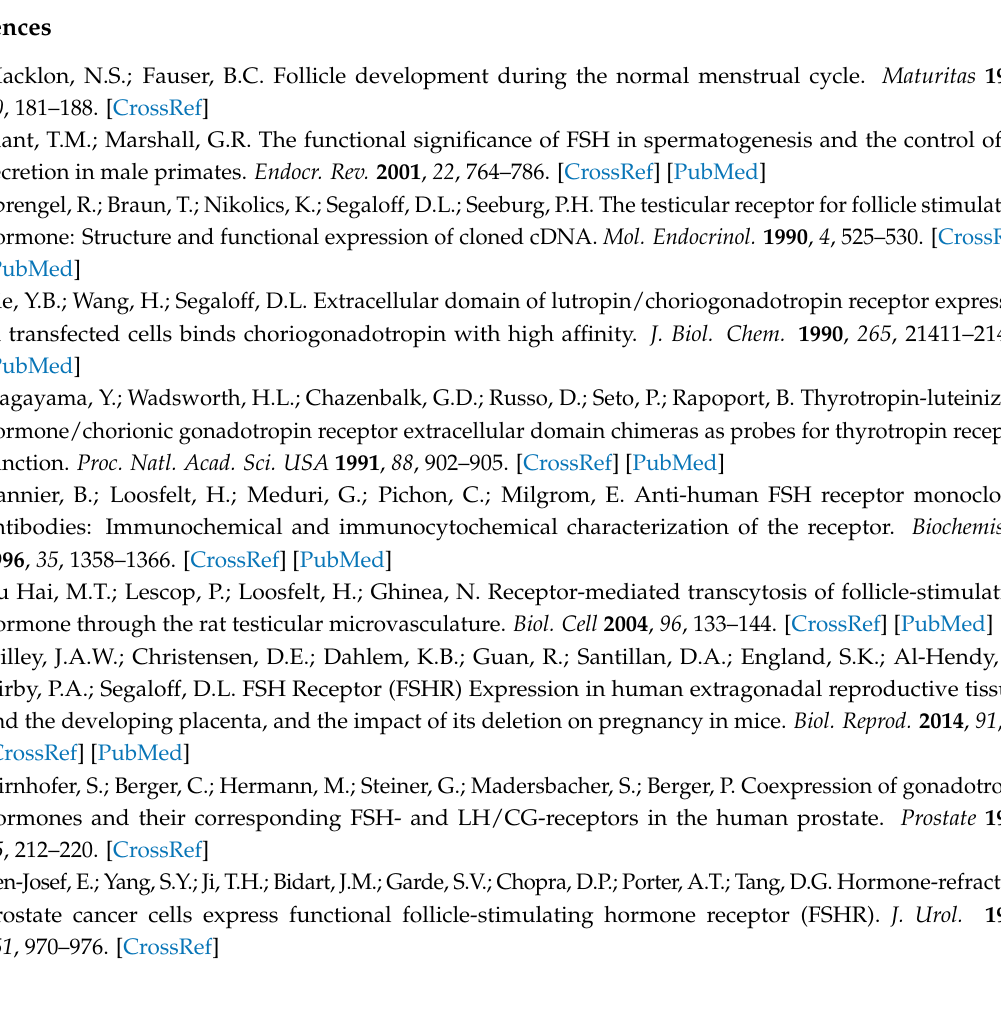
Figure S1: Analysis of overall specificity of IgG molecules using Protein Panel Profiling